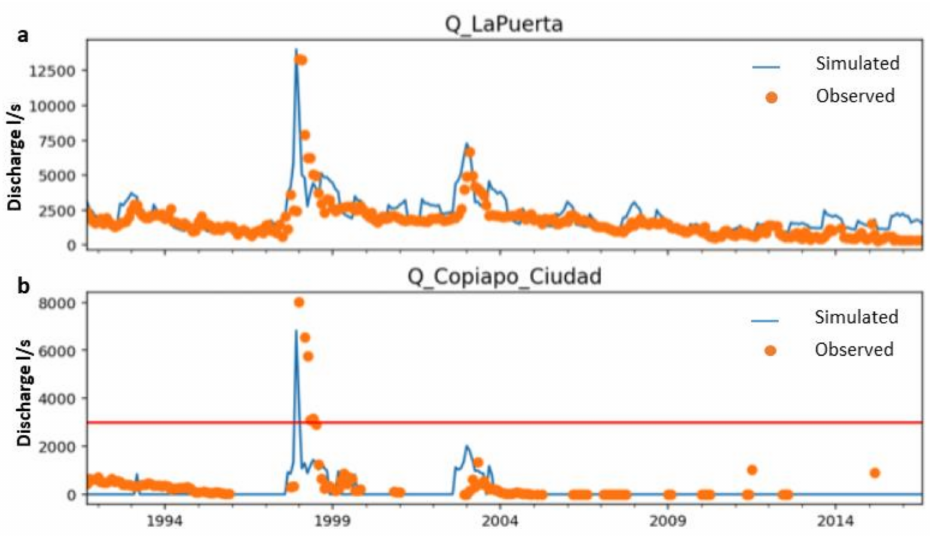
Figure 6. Simulated versus observed discharges in ( a ) “Rio Copiap ó en La Puerta” and ( b ) “Rio Copiap ó en Ciudad” gauging stations. Horizontal red line represents the average controlled discharge from Lautaro Reservoir (3020